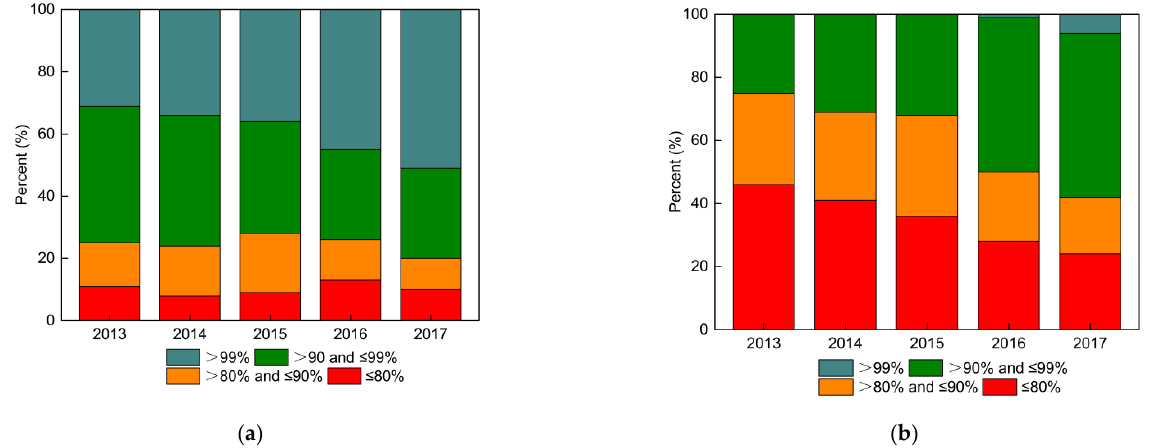
Figure 13. Trends in dust removal efficiency for ( a ) cement industry and ( b ) steel industry.